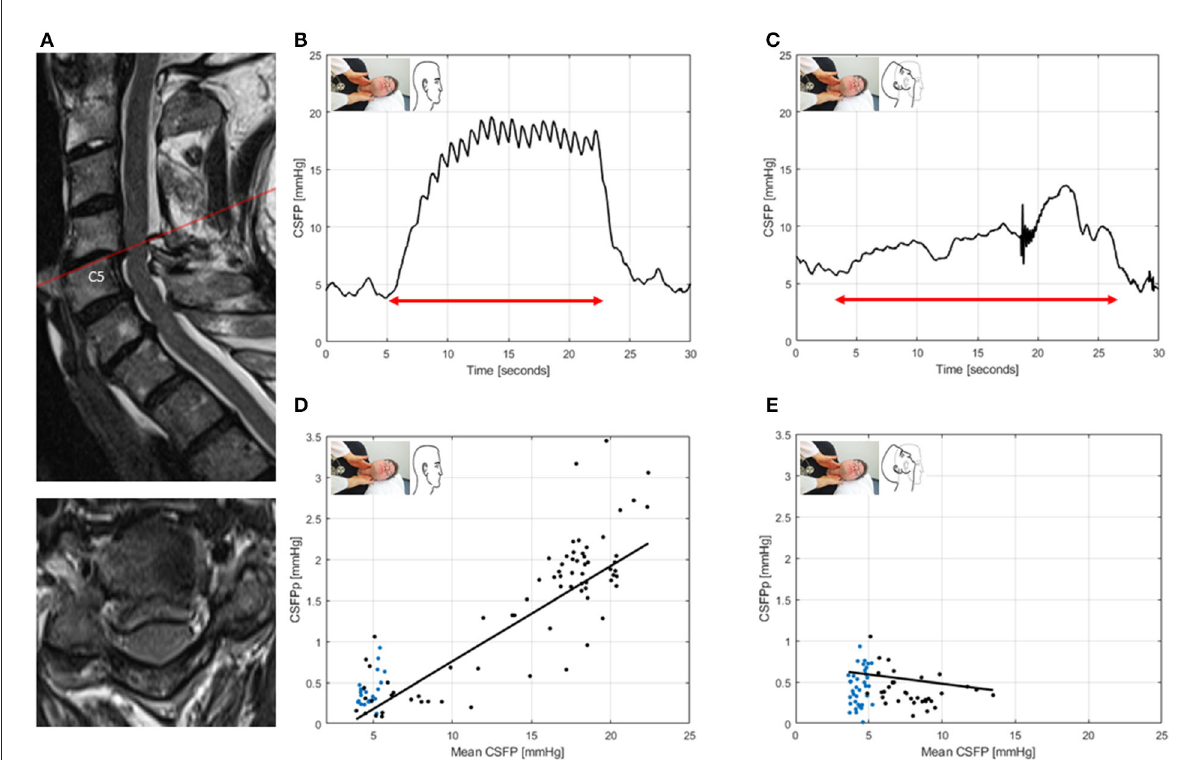
FIGURE4 T2-weighted MRI of the cervical spine for ID2 (patient with degenerative cervical myelopathy, mJOA: 17) (A) . Sagittal and axial images showing spinal canal stenosis maximum at level C4/5, without clear cord compression. CSFP is shown during the Queckenstedt’s test in neutral head position (rise, 15.2 mmHg) (B) , which declines in head reclination (rise, 7.2 mmHg) (C) . Cardiac-driven CSFP peak-to-trough amplitude (CSFPp) at resting state (blue dots) and during the Queckenstedt’s test (black dots) is plotted against mean CSFP (D) . The regression line (in black)